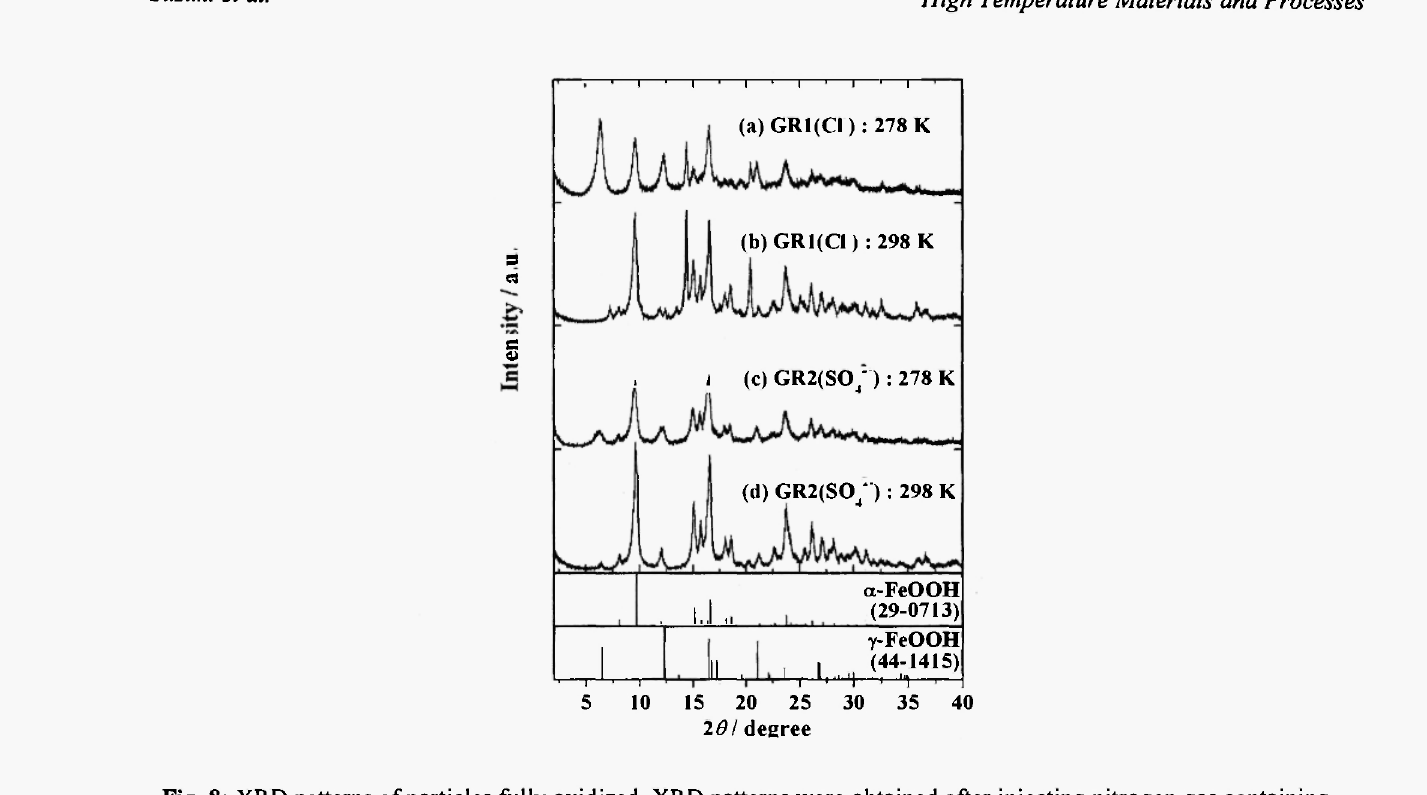
Fig. 8: XRD patterns of particles fully oxidized. XRD patterns were obtained after injecting nitrogen gas containing 21% oxygen into the GR1(C1") and GR2(S0 42 ~) suspension at 278 and 298 K. This is because the aqueous solution and glycerol may influence the XRD patterns for samples extracted from the suspension, and residual ions in the solution were precipitated in the freeze-dried samples. The results show that α-FeOOH with a small amount of γ-FeOOH was formed from GRl(CP) and GR2(S0 42 ~) at 298 K, although peaks observed at approximately 14° and 20° in the XRD patterns for GRl(Cr) are assigned to NaCl precipitated from the solution. The amount of α-FeOOH formed from GR1(C1") and GR2(S0 42 ~) was higher at 278 Κ than at 298 K. In particular, the amount of α-FeOOH formed from GRl(CP) was considerably high, and the XRD peaks for α-FeOOH formed from GRl(CI-) were broad. This indicates that the α-FeOOH particles are poorly crystallized at lower temperature, which may be induced by the rapid precipitation of Fe(III) ions from aqueous